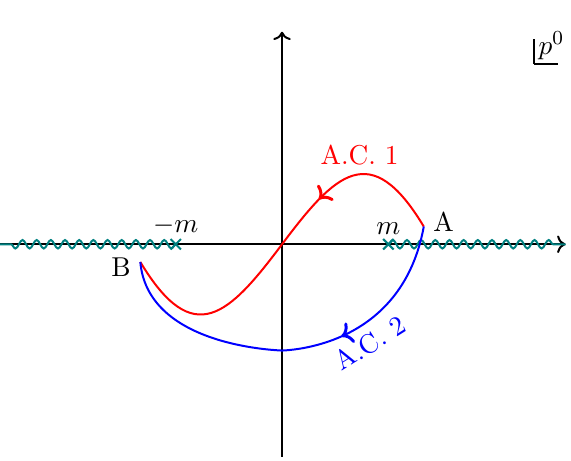
Figure 11 . The complex p 0 plane. We depict the analytic structure of the function p ( p 0 ) defined in (E.5). It has two branch cuts. The original domain of the function p is given by positive values p 0 slightly above the right cut. We define p for negative values of p 0 by an analytic continuation. The two different options are depicted in red and blue. Two paths together encircle the + m branch point and thus differ by a monodromy around that